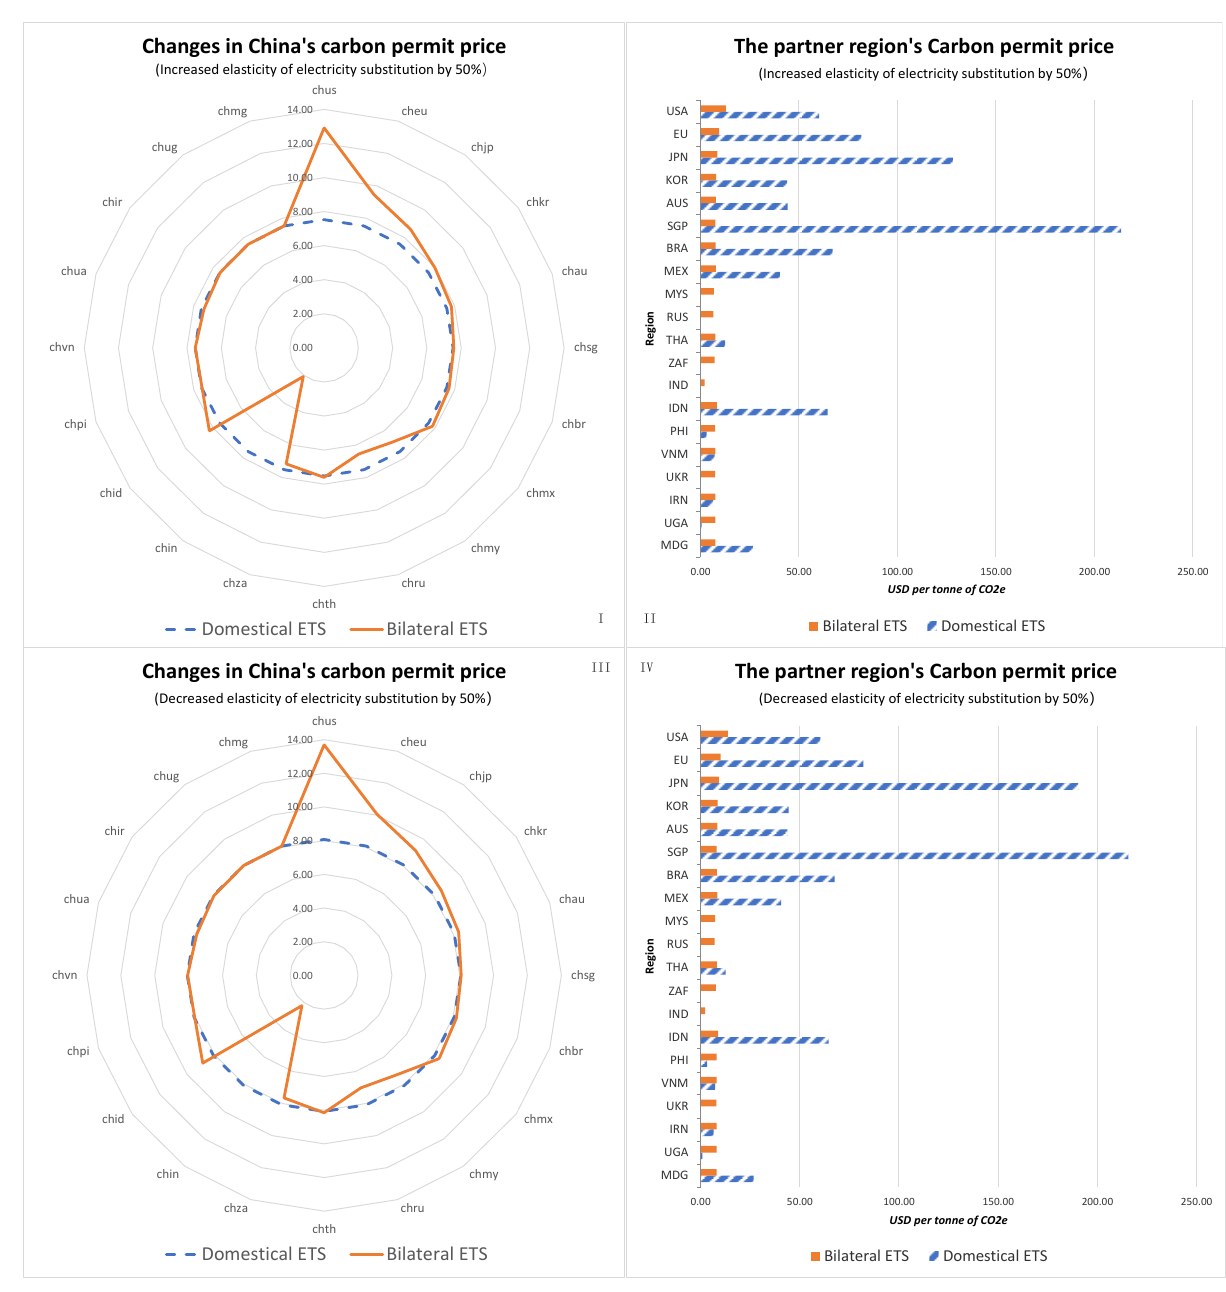
Figure 8. Robustness of the endogenous carbon prices in the ETS. ( I , IV ), carbon permit price change in China ( I ) and its partner regions ( II ) while the elasticity of electricity substitution increased by 50% under domestic ETS and ETS linking scenarios. Carbon permit price change in China ( III ) and its partner regions ( IV ) while the elasticity of electricity substitution decreased by 50% under domestic ETS and ETS linking scenarios.